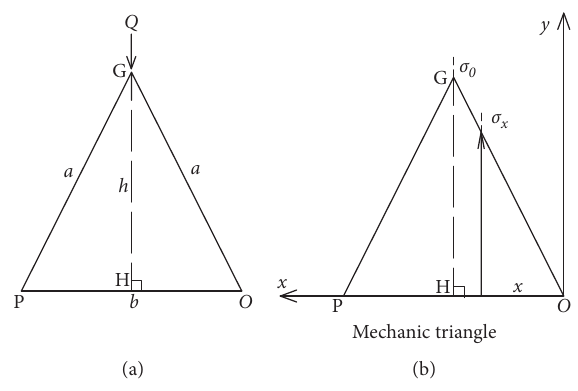
Figure 5: Distribution of force. (a) Geometric triangle. (b) Mechanic